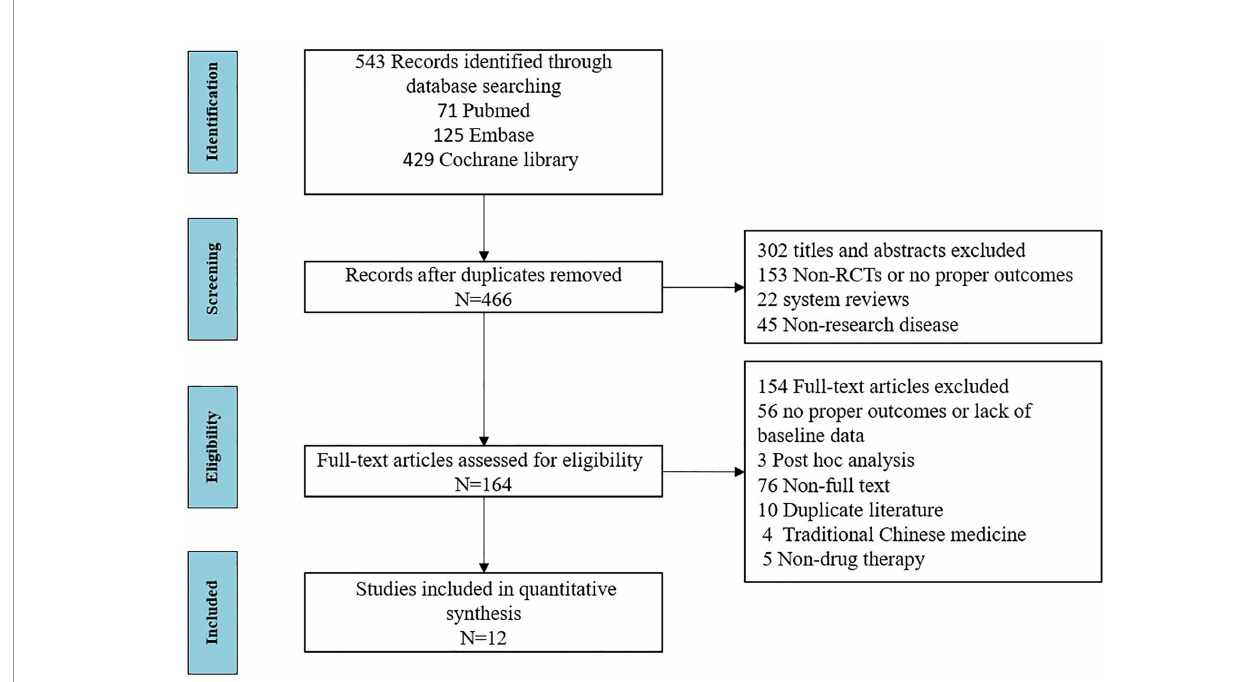
FIGURE 1 | Flow chart for study identi fi cation and